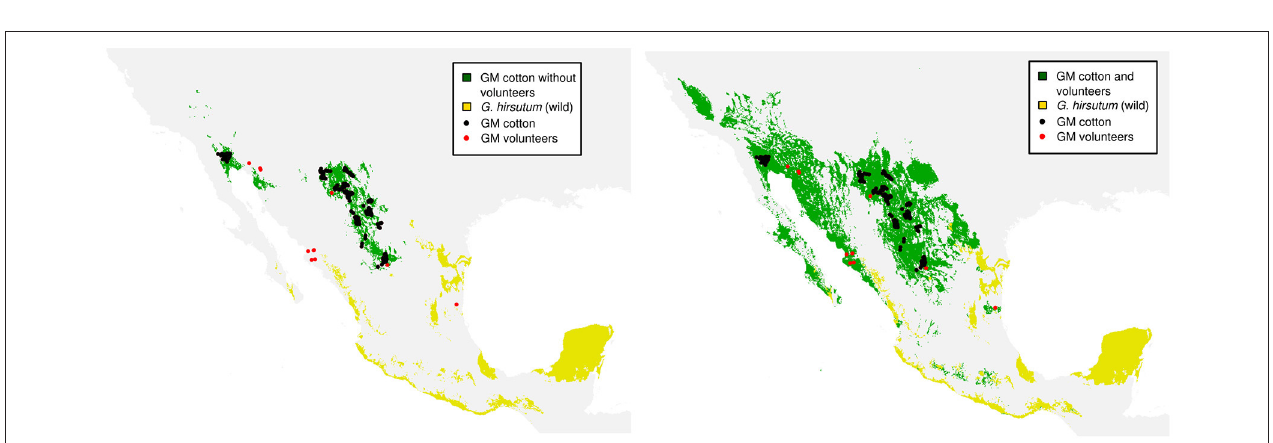
FIGURE 3 | Principal Component Analysis (PCA) of environmental conditions of the analyzed cotton records (wild, GM, and volunteer). Conditions in which GM cotton is planted (blue dots) are very restrictive and differentiable from the rest of the cotton species (wild in black, gray, and colors). GM volunteers are represented with red dots.